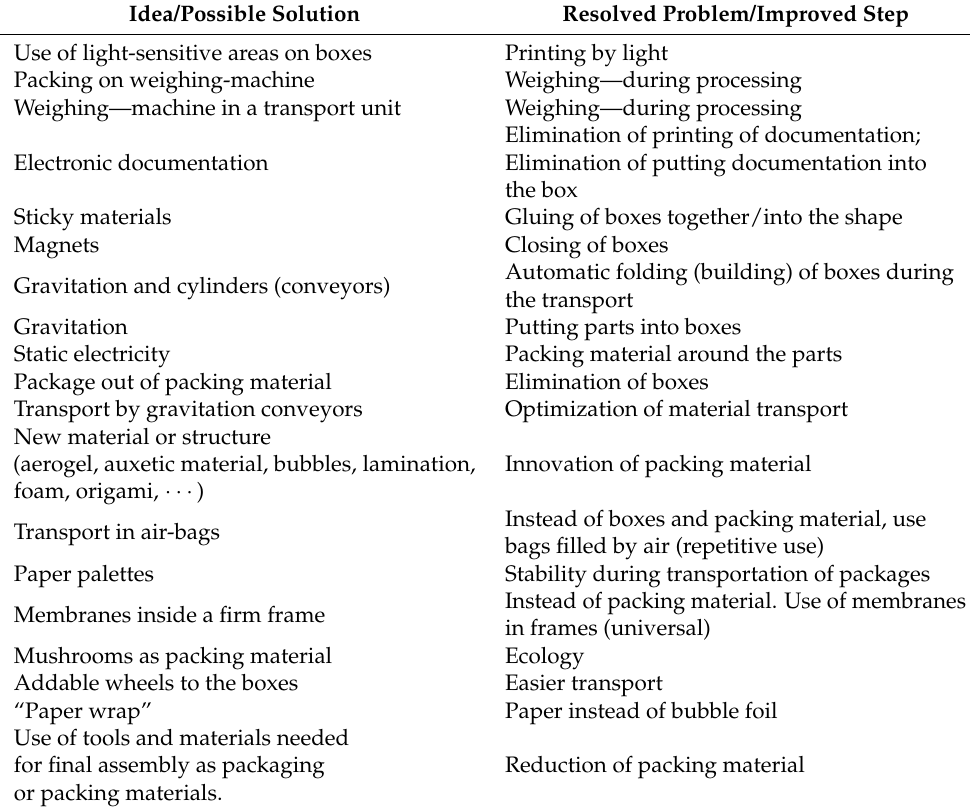
Table 3. Comparison of the original and improved state of the packing